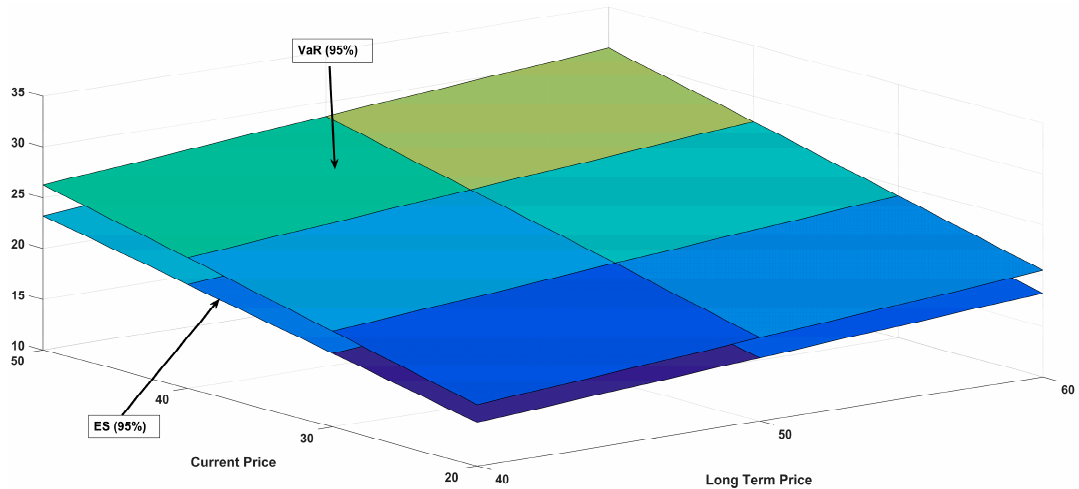
Figure 9. Sensitivity of VaR(95%) and ES(95%) to the spot price ( S 0 ) and future price ( * 0 S ).